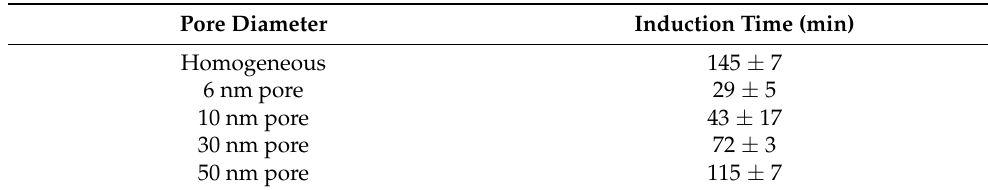
Table 1. Average induction time of diglycine in the absence and presence of porous silica at S = 1.20; volume = 40 mL; T sat = 40 °C; T cry = 32.7 °C.